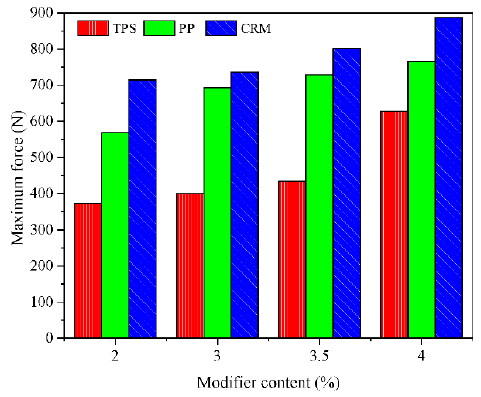
Figure 5. Effect of modifier content on max force. Figure 5. E ff ect of modifier content on max